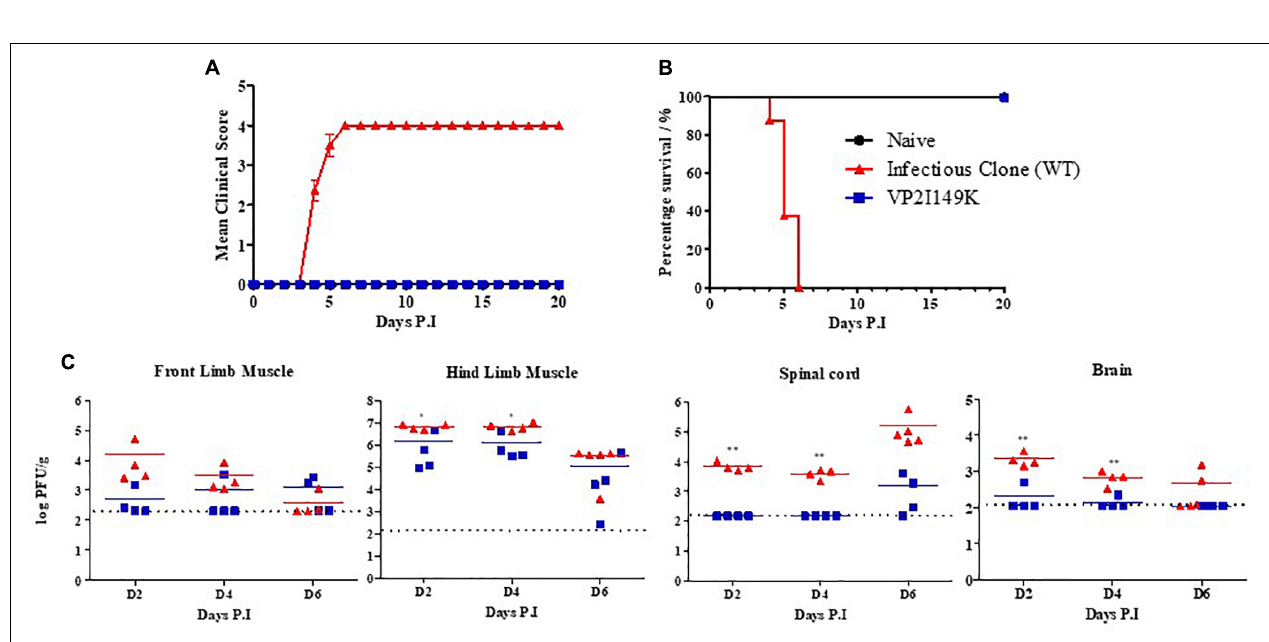
FIGURE 5 | Effect of mSCARB2-siRNA knockdown on S41 WT infection in NSC-34 cells. NSC-34 cells were reverse-transfected with mSCARB2 siRNA (pool or deconvoluted) or siRNA non-treated control (NTC), followed by infection with WT S41 virus at MOI of 10 (A,B) or transfection with purified S41 viral genome (C) . (A,C) Viral titers in the culture supernatants sampled at 48 h (A) and 18 h (C) post-infection were determined by plaque assay. The horizontal dashline indicates the detection limits of 500 PFU/mL (A) and 20 PFU/mL (C) , respectively. Two-tailed student t -test was conducted with ** p < 0.01. Data were expressed as mean ± SD. (B) SCARB2 and viral VP0 in cell lysates from experiment (A) were probed by immunoblotting. Histone H2B was used as loading control. Band intensities were normalized to untreated non-infected control (UT).